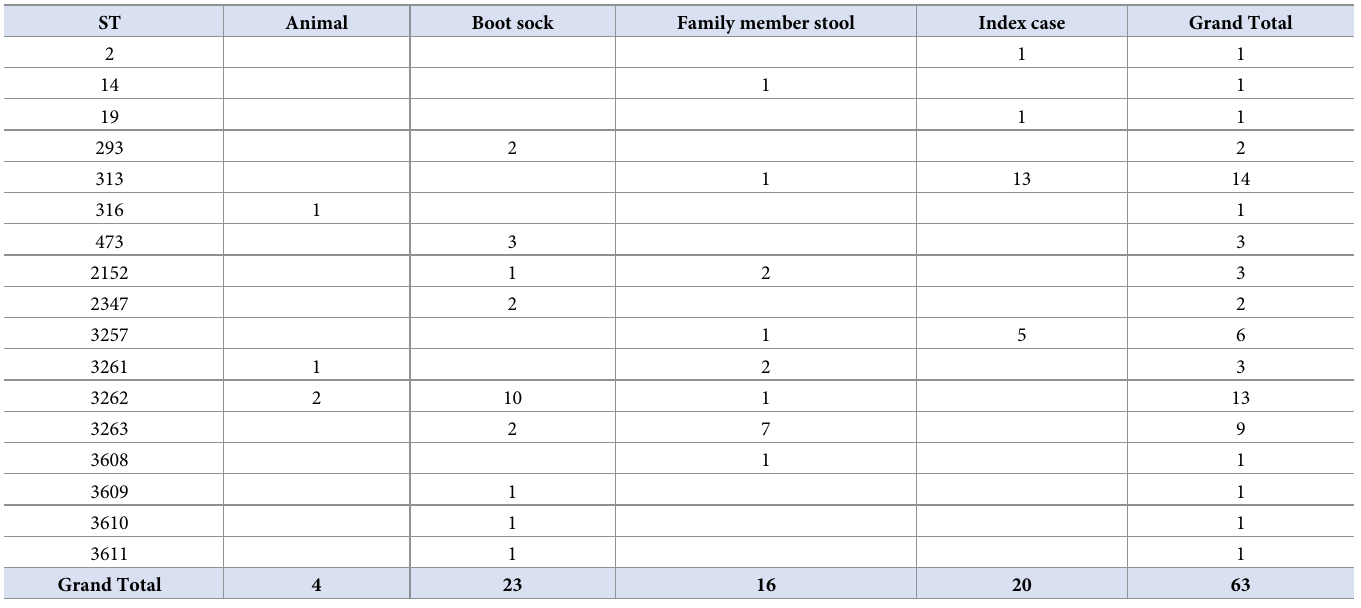
Table 3. The number of isolates belonging to each ST identified in this study, from each niche. ST Animal Boot